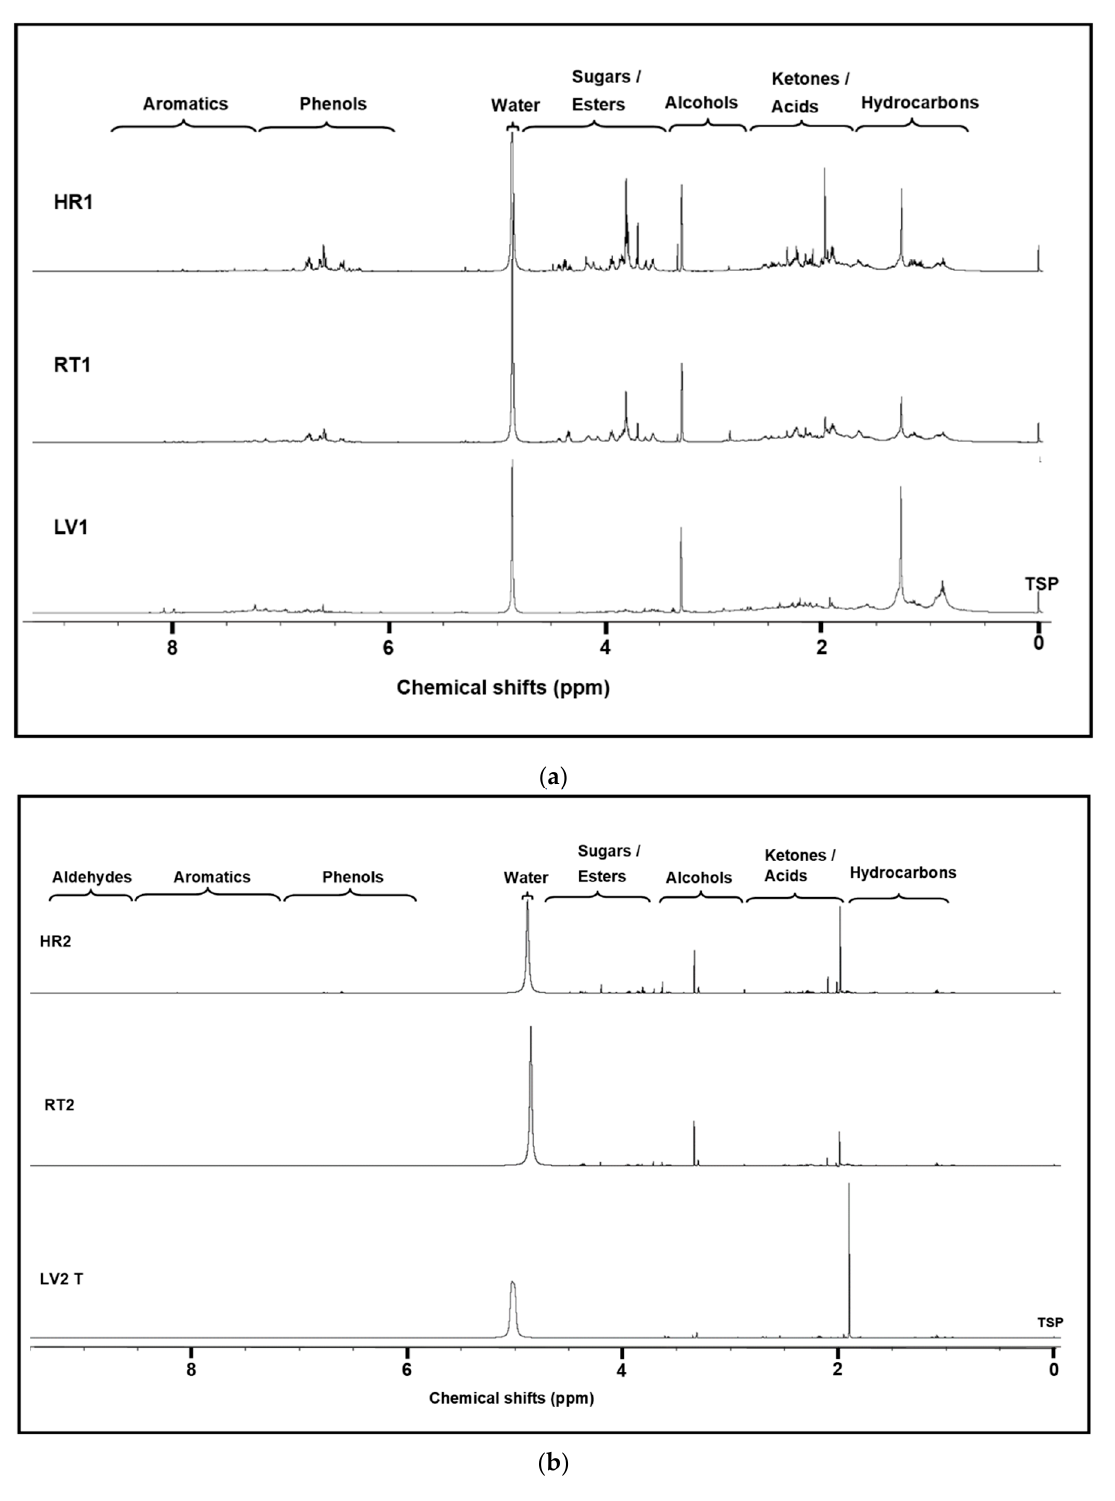
Figure 2. ( a ) Comparison of the proton nuclear magnetic resonance ( 1 H NMR) spectra of hemp distillates pyrolyzed and condensed at temperatures 275–350 °C and 130 °C, respectively. ( b ) Comparison of the 1 H NMR spectra of hemp distillates pyrolyzed and condensed at temperatures 275–350 °C and 70 °C, respectively.